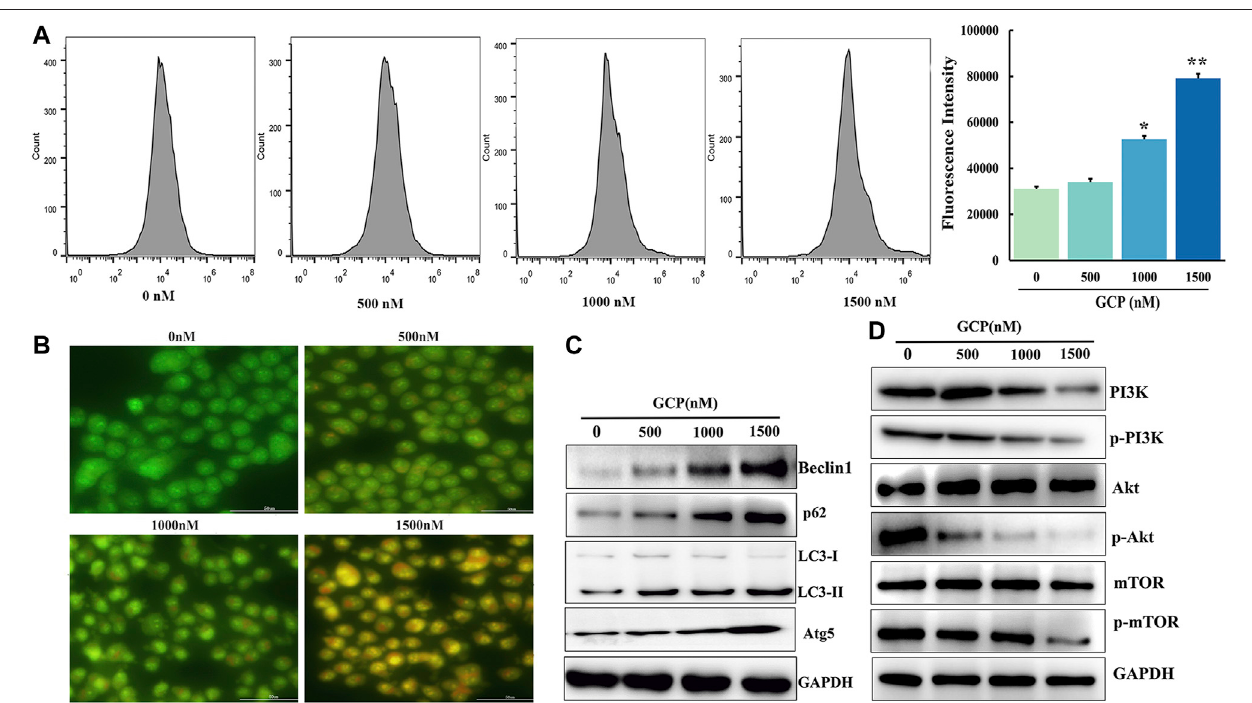
FIGURE 6 | GCP induces autophagy in HeLa cells via the PI3K/Akt/mTOR signaling pathway. (A) Flow cytometry assay to detect autophagy level using by MDC staining, * p < 0.05, ** p < 0.01 vs control. (B) Acridine orange staining was used to detect autophagic vacuoles. (C) The level of autophagy-related protein and (D) PI3K/ Akt/mTOR signaling pathway protein expression shown by western blot